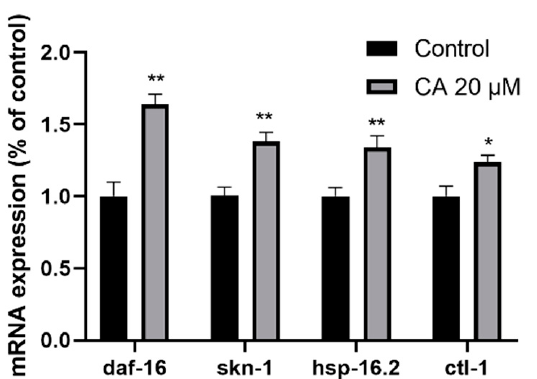
Figure 8. Effect of CA on aging-related gene expression in C. elegans. Wild-type worms were treated with DMSO (control) or with 20 µ M CA for 3 days, followed by extraction of total RNA and RT-qPCR, as described in the Methods. The relative mRNA expression of skn-1 , ctl-1 , daf-16 , and hsp-16.2 are presented ( n = 250–300 worms per group). The difference was examined with student’s t -test, * p < 0.05, ** p ≤ 0.01 vs. control.